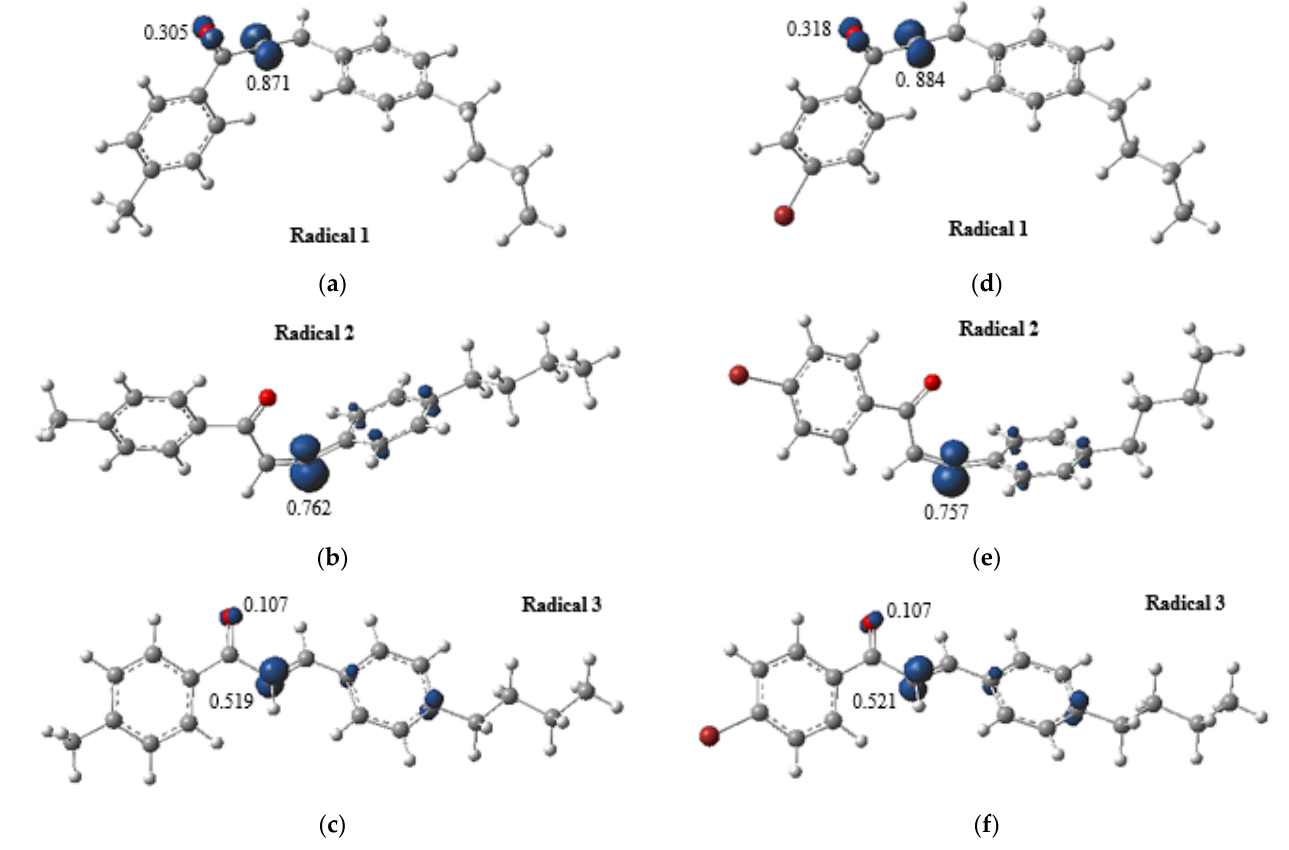
Figure 8. Electron spin densities isosurface at ρ(r) = 4.0 × 10 − 2 electrons/Bohr3 contour of the total SCF electronic density for ( a ), ( b ), ( c ) BMP and ( d ), ( e ), ( f ) BBP radicals at the M06-2X/6-311++G(d,p) level of theory.